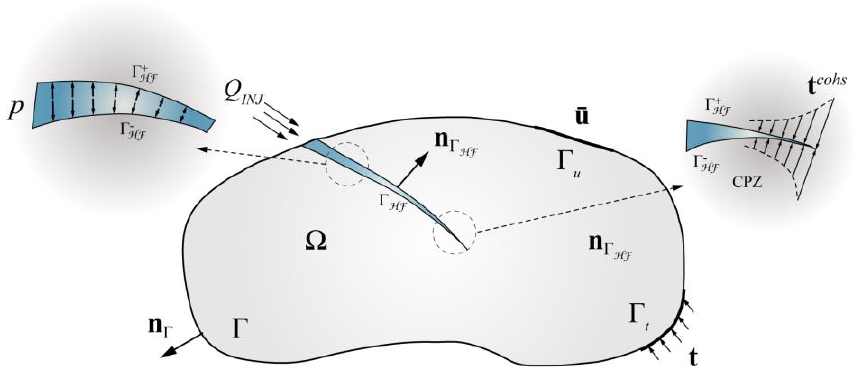
Figure 1. The definition and boundary conditions of a hydraulic fracturing body within a geomechanical discontinuity.